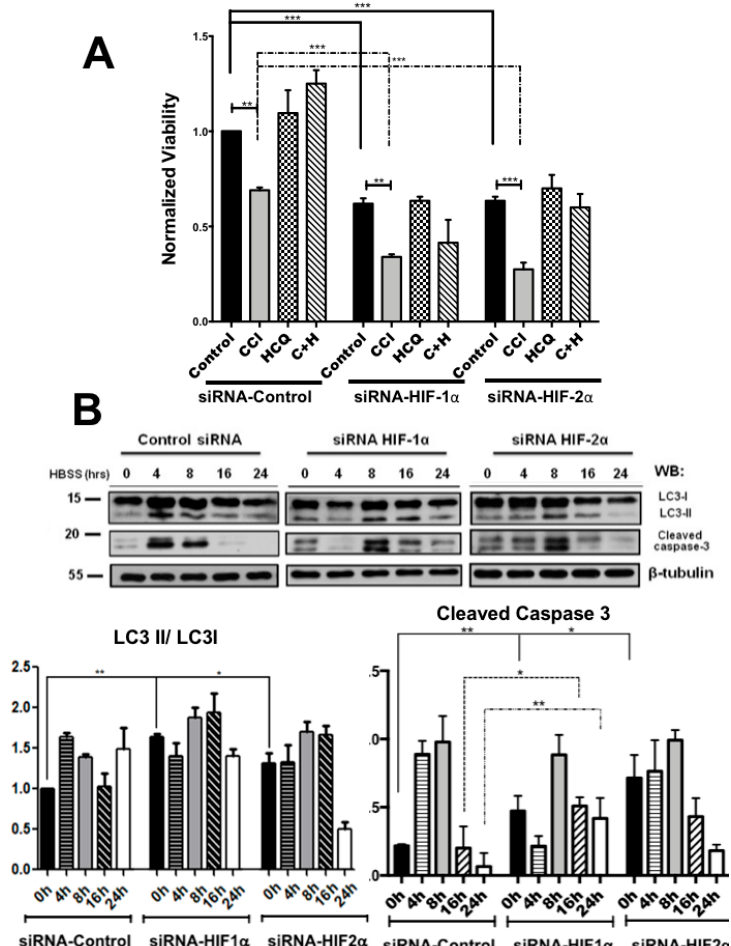
Figure 2. ( A ) Cell viability diminishes mainly as a result of HIFs-silencing expression. SW480 cells were incubated 48 h in the absence or presence of several concentrations of the drugs (the mTORC1 inhibitor CCI-779 or the autophagy inhibitor hydroxychloroquine) alone or in combination, as indicated in the figure. The cell viability was measured with the MTT assay as described in the Materials and Methods section. The bar graph represents the mean ± SEM of three independent experiments. ** p < 0.01; *** p < 0.001. ( B ) Nutritional stress-induced autophagy in both HIF-expressing or HIF-silenced SW480 cells, but both autophagy and apoptosis rates were bigger in HIFs- depleted cells than in controls. Growth medium from control or HIF-silenced cells was replaced with Hanks’ balanced salt solution (HBSS). Cells were collected at the time points indicated in the Figure and examined by Western blotting to detect autophagy and apoptosis as indicated in the Figure. β -tubulin was used as a control for equal loading. The results shown are representative of at least three independent experiments. Densitometric analysis was performed to estimate the changes in LC3II/I ratio and in cleaved Caspase 3 levels compared to the levels found in control HIFs expressing cells (bar graphs) and data represents the means ± SEM of at least three independent experiments. * p < 0.05; ** p < 0.01.